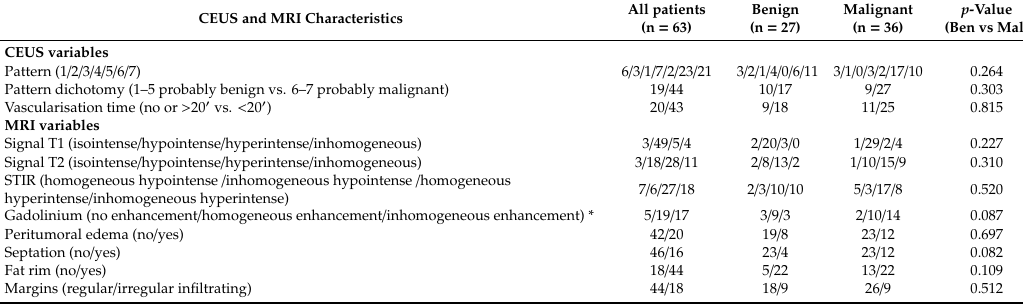
Table 3. Univariate analysis of Contrast-enhanced ultrasound (CEUS) and magnetic resonance imaging (MRI) data in relation to histological